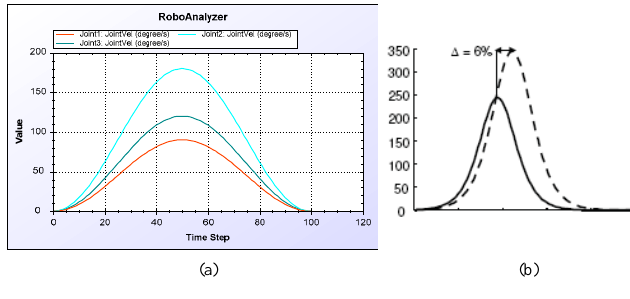
Figure 10(a) shows the velocity profiles of prosthetic hand index finger joints. Velocity profile of human hand fingers as reported in [5] is shown in Figure 10(b).